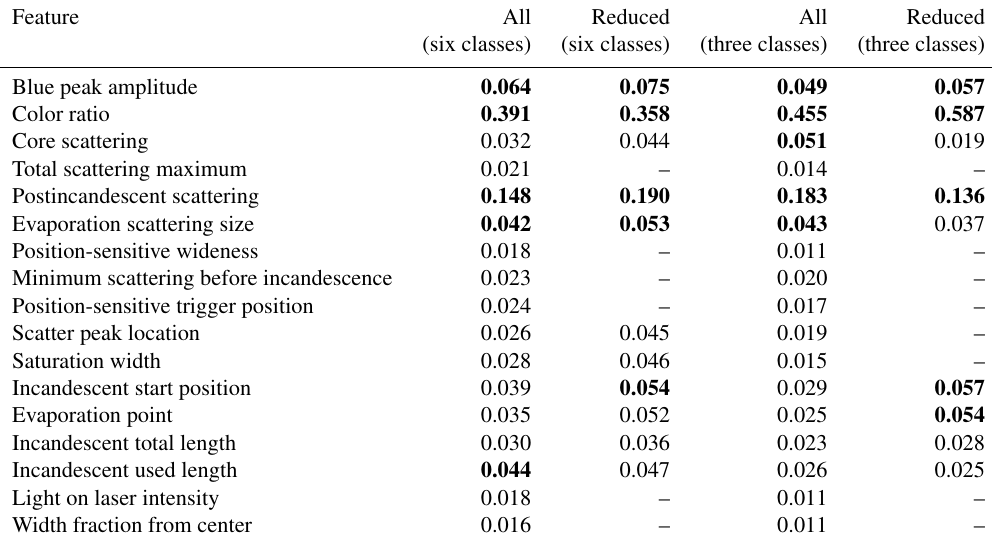
Table 3. Importance of different features. The relative importance of the different features for the optimal random forest for the six-class and three-class cases. All denotes that all 17 features were used in the algorithm, and reduced indicates that only a subset of features were included as input to the learning algorithm (11 features for the six-class case and 9 features for the three-class case). The top five most important features in each category are